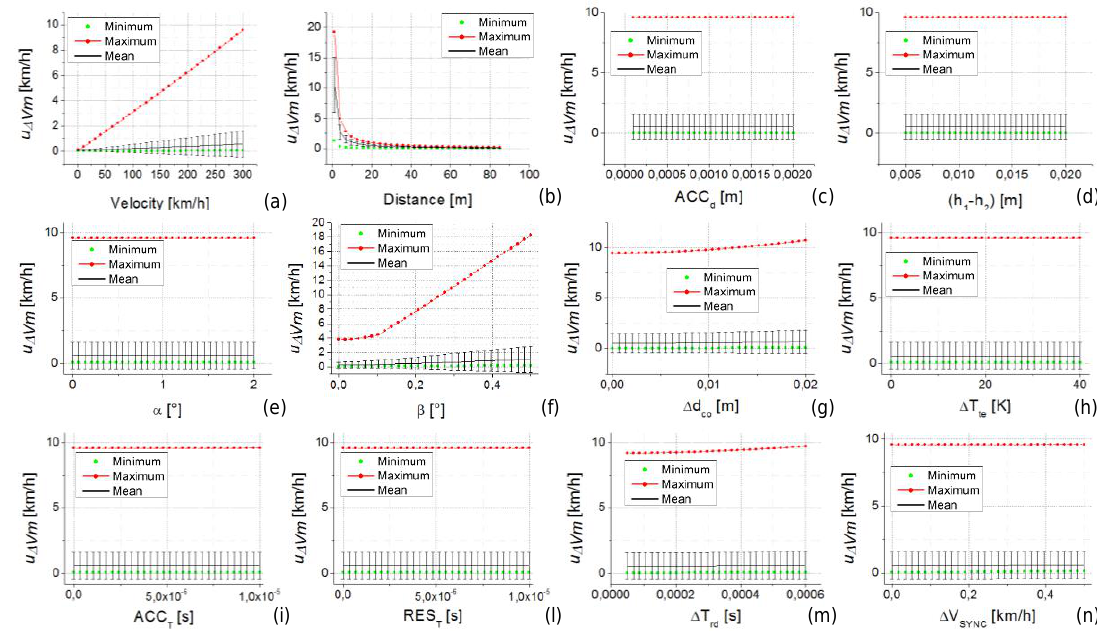
Figure 11. Uncertainty of the calibration method ( 𝑢 ∆𝑉 ) versus the uncertainty contribution parameters. In each plot from ( a – n ) the independent variable is one parameter. The plots are relative to the case study 4 (all the parameters are randomly selected inside their own range of variability reported in Table 2—except the case (a) where the speed is fixed at 300 km/h). The black bars near the mean values represent the standard deviation of the 𝑢 ∆𝑉 calculated on the 1000 random repetitions.